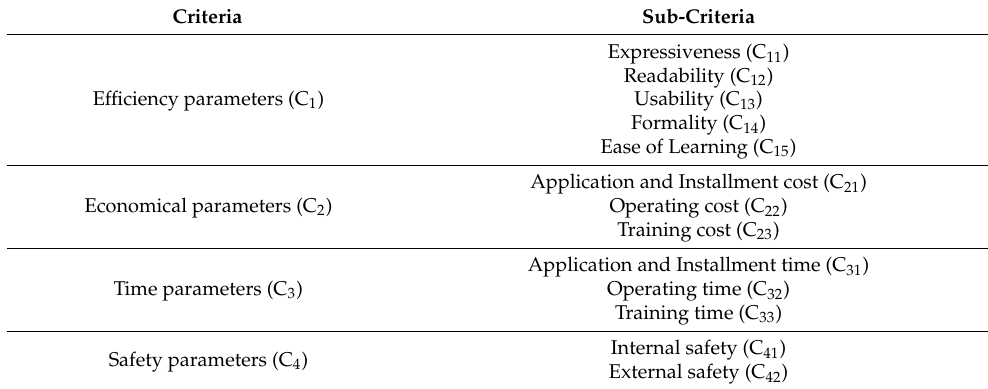
Table 1. The criteria and sub-criteria for BPM tool